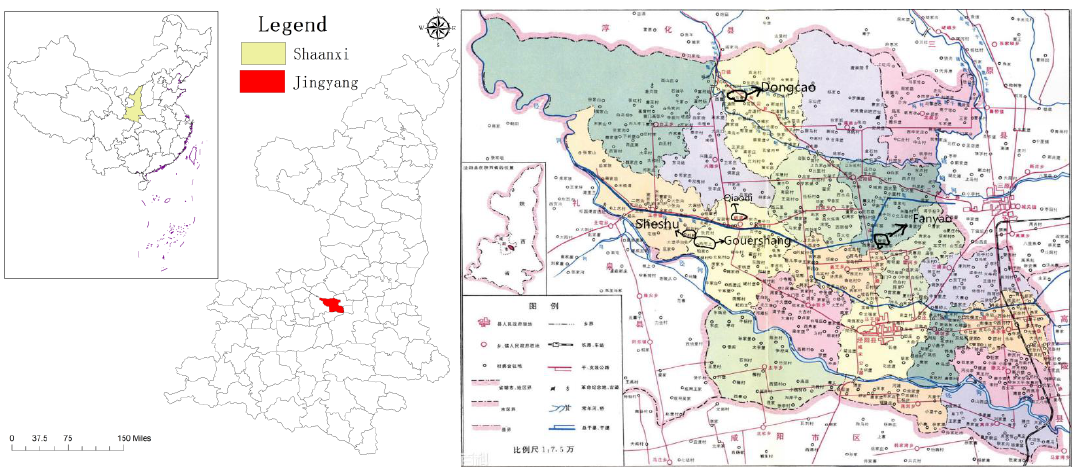
Figure 1. Study area in arid